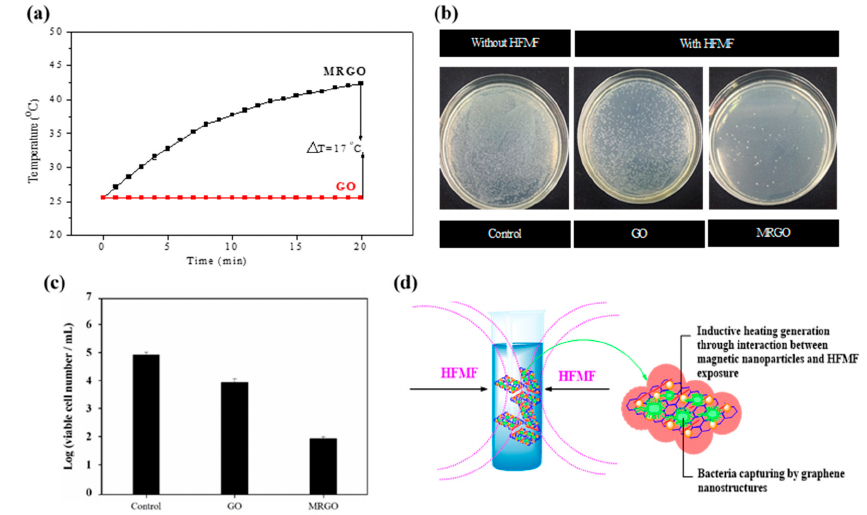
Figure 7. ( a ) Inductive heating temperature of GO and MRGO by high frequency magnetic field (HFMF); ( b ) bacteria activity with and without HFMF exposure; ( c ) survival S. aureus numbers of GO and MRGO by HFMF; ( d ) schematic diagrams of bacteria capturing activity and HFMF exposure.